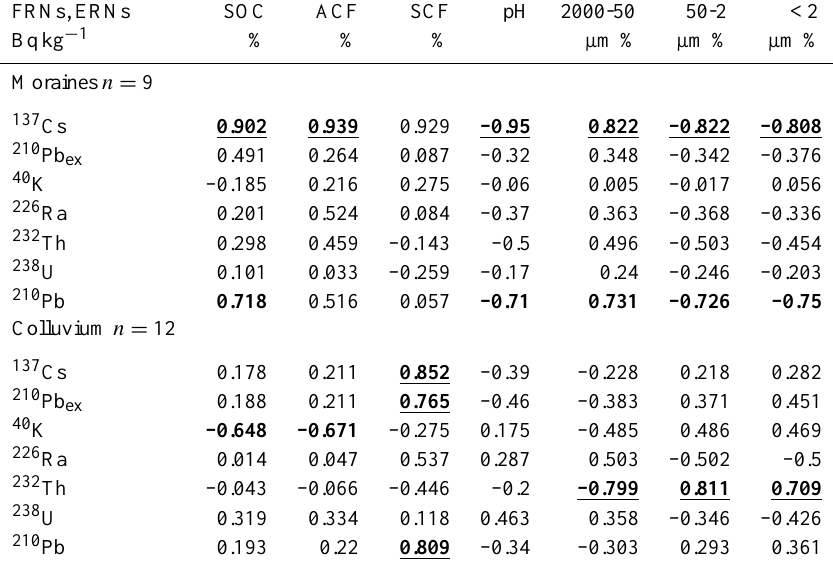
Table 8. Pearson correlation coefficients among soil properties FRN and ERNs in the samples of the soil profiles of the moraines and colluviums. Bold face numbers are significant at the 95% confidence level, underlined numbers are significant at the 99% confidence